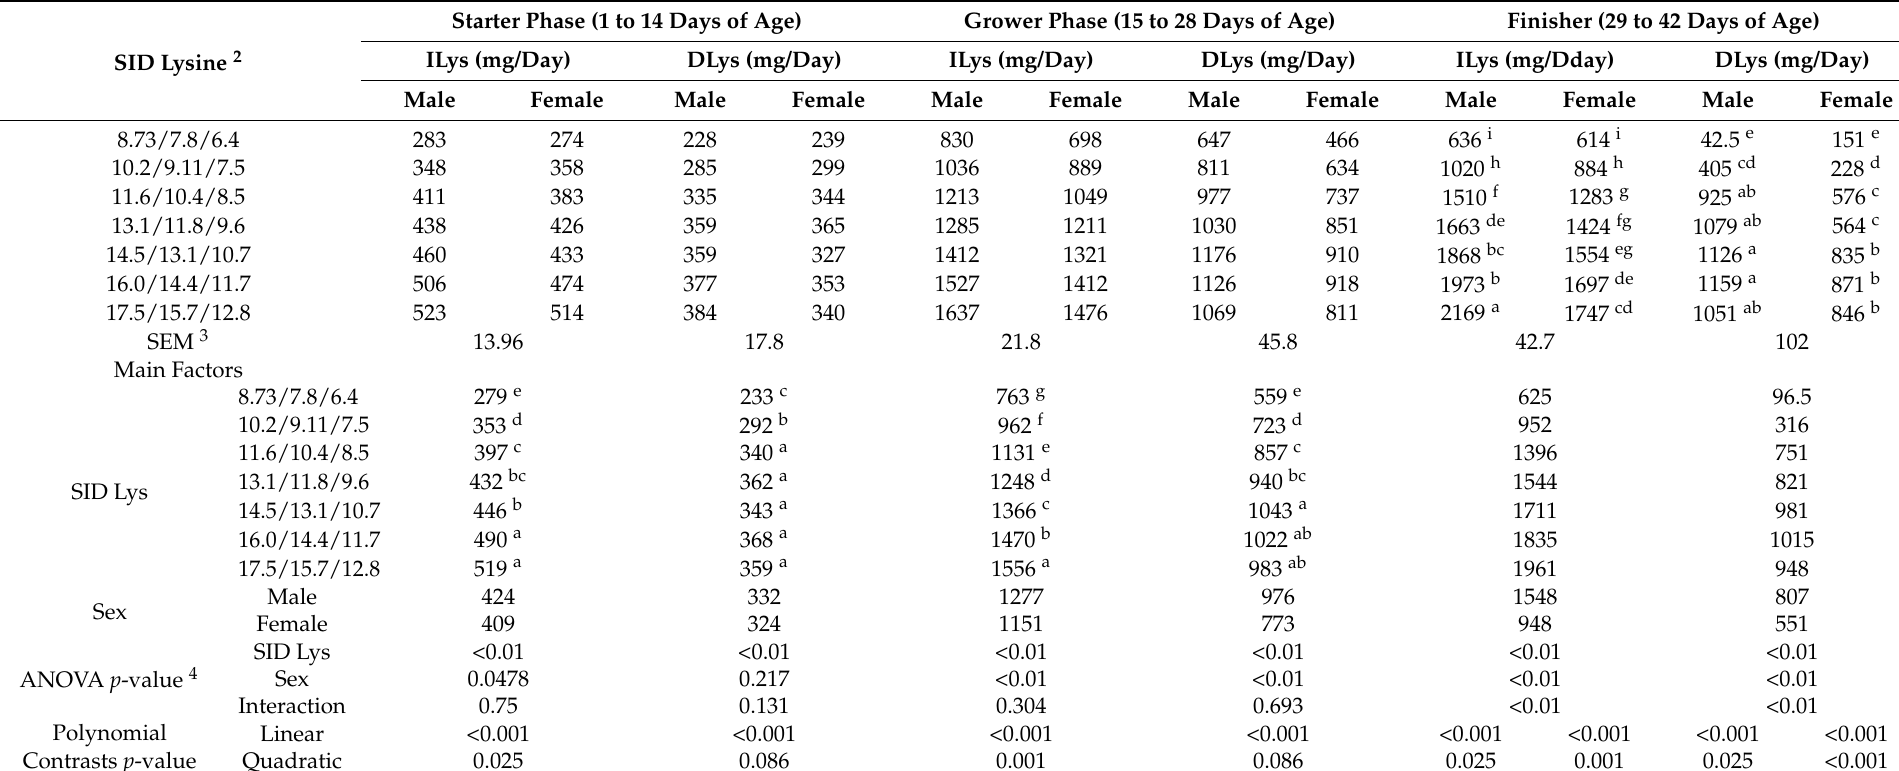
Table 5. Effects 1 of standardized ileal digestible levels (SID Lys) in intake (iLys) and deposition on body and feathers (DLys) on male and female broiler chickens in the starter, grower, and finisher